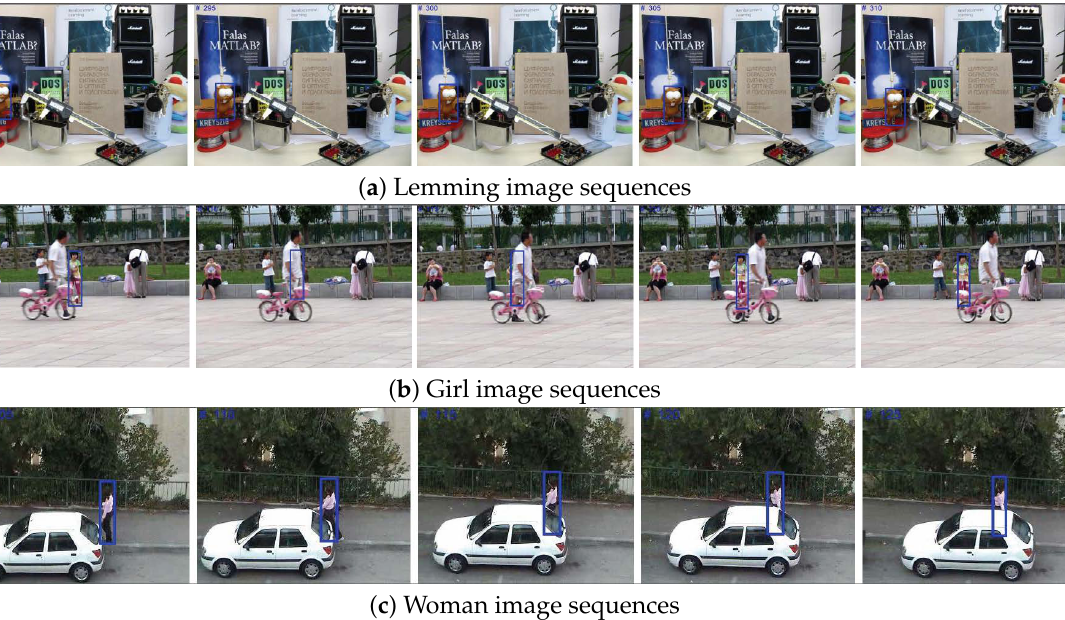
Figure 5. Tracking during partial occlusion and